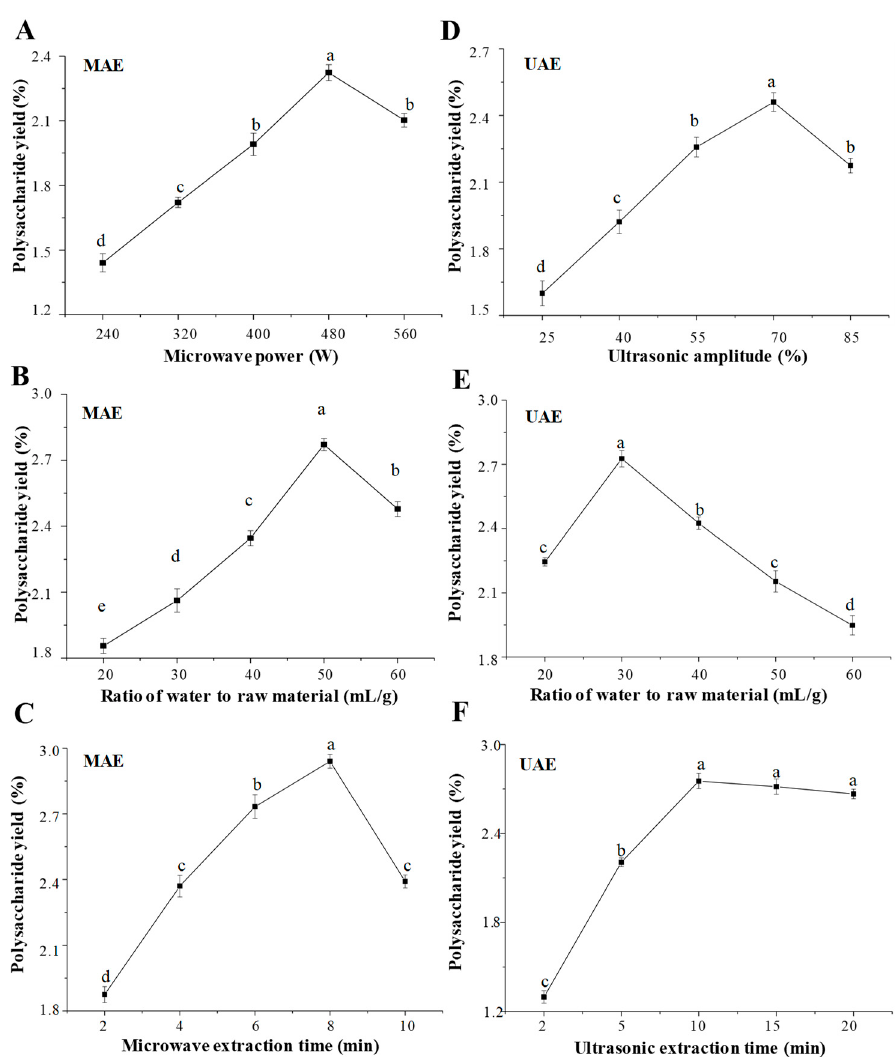
Figure 1. Effects of different extraction parameters of microwave-assisted extraction (MAE) and ultrasonic-assisted extraction (UAE) on the yields of polysaccharides extracted from kiwifruit. ( A – C ) the microwave power, ratio of water to raw material, and microwave extraction time of microwave-assisted extraction; ( D – F ) the ultrasonic amplitude, ratio of water to raw material, and ultrasonic extraction time of ultrasonic-assisted extraction; The error bars are standard deviations; significant ( p < 0.05) differences are shown by data bearing different letters (a–e); Statistical significances were carried out by ANOVA and Ducan’s test.